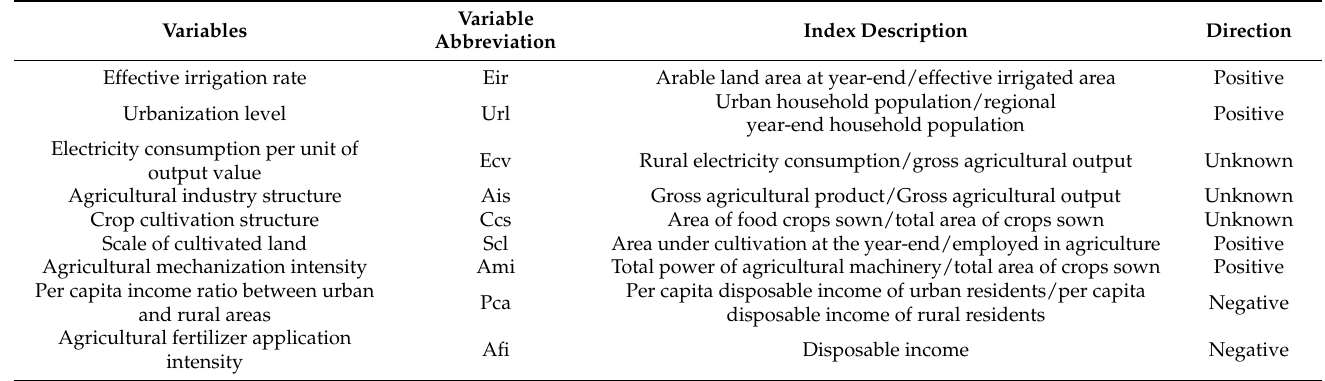
Table 3. Explanatory variable, index description, and symbol prognosis of